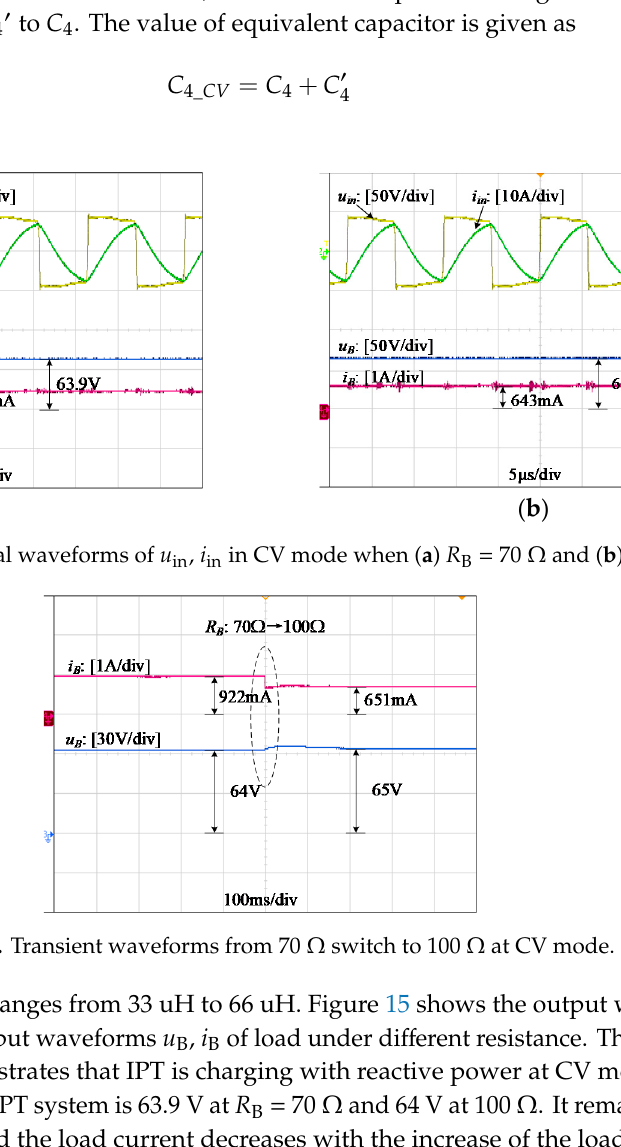
Figure 17. Transient waveforms of i in , u B and i B from CC mode to CV mode